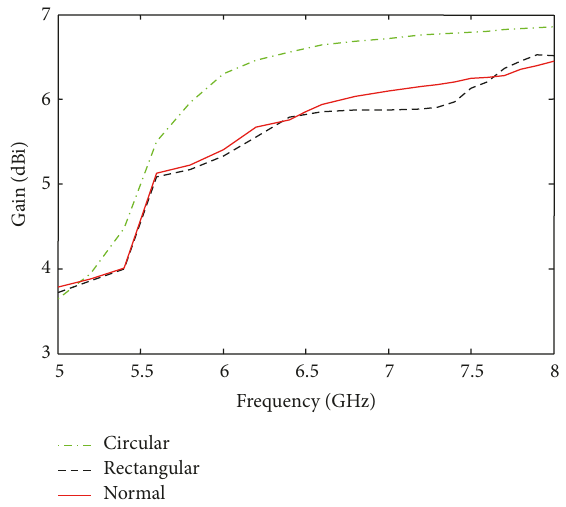
Figure 9: Gain of the designed antennas as a function of